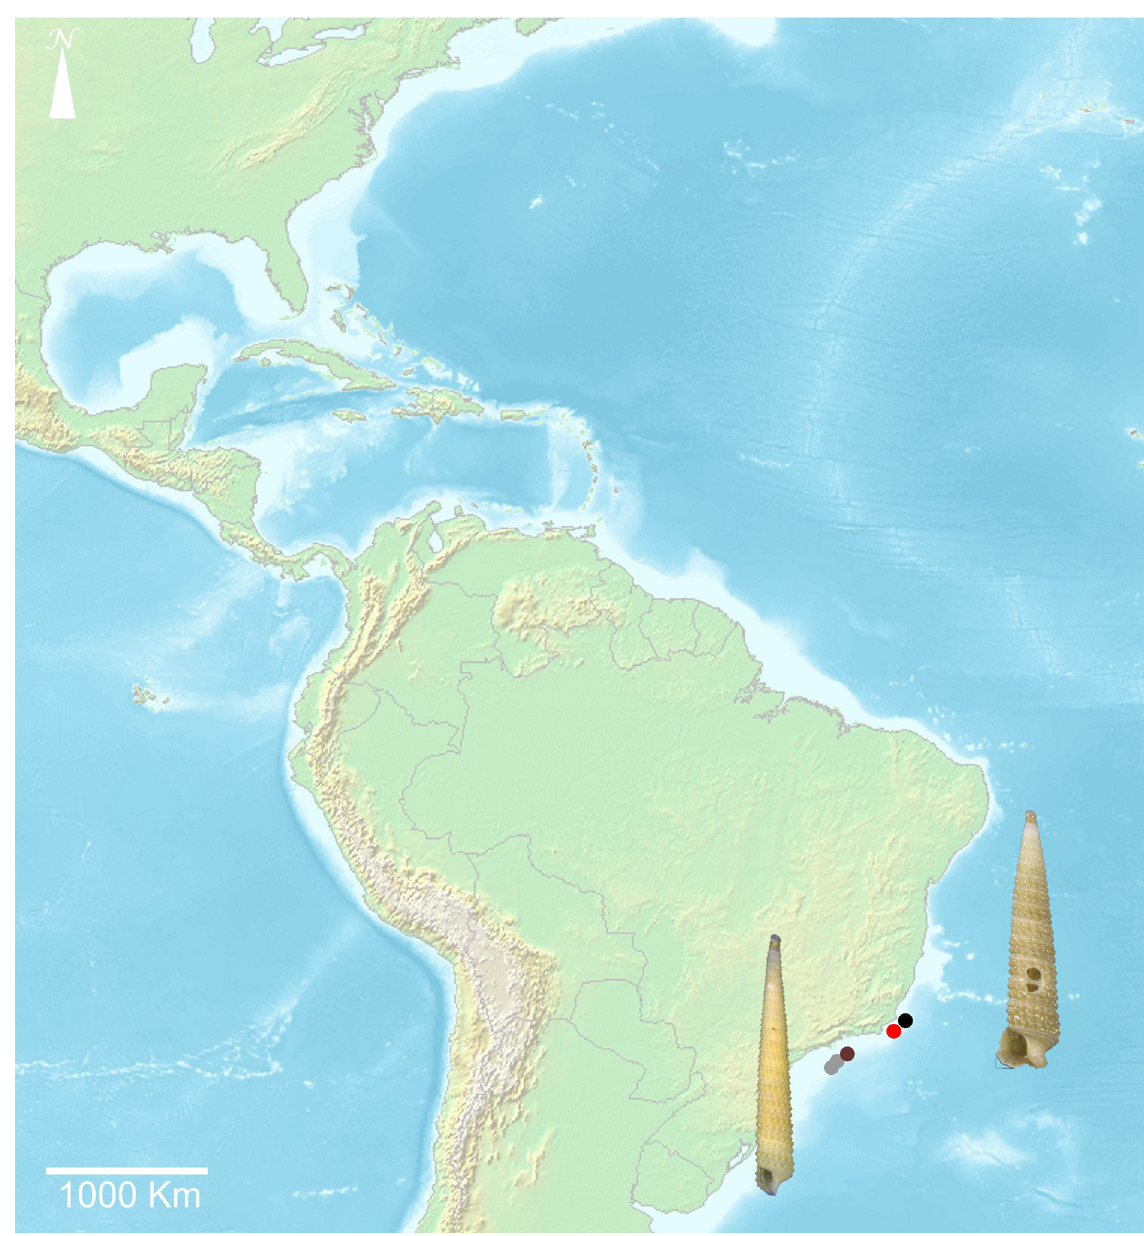
Fig. 73. Distribution map of Strobiligera campista Fernandes & Pimenta, 2019 (red circle = type locality; black circle = additional locality) and Strobiligera santista Fernandes & Pimenta, 2019 (brown circle = type locality; gray circles = additional